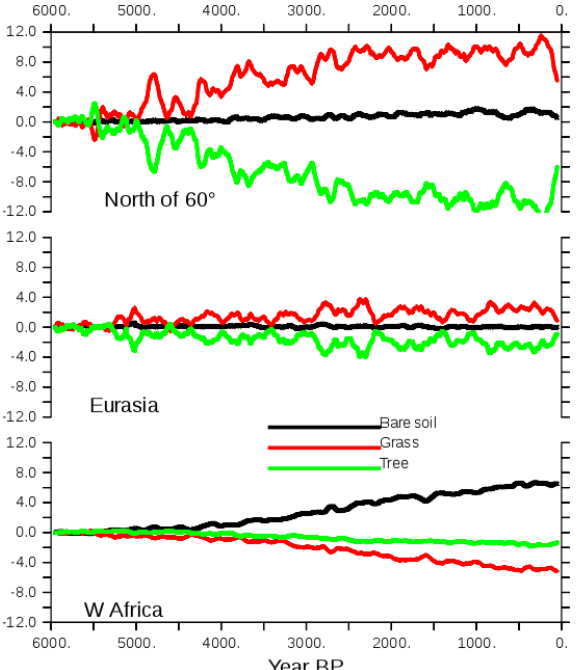
Figure 11. Long-term evolution of bare soil, grass, and trees, ex- pressed as the percentage of land cover north of 60 ◦ N, over Eura- sia, and over West Africa. The different values are plotted as differ- ences with the first 100-year averages. A 100-year running mean is applied to the curves before plotting.